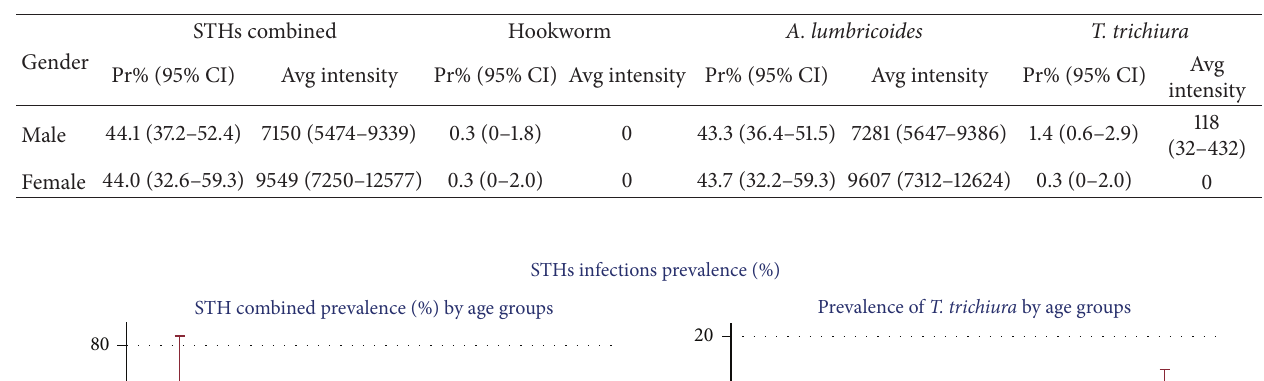
Table 4: Prevalence and mean intensity of soil-transmitted helminths (STHs) per gender.